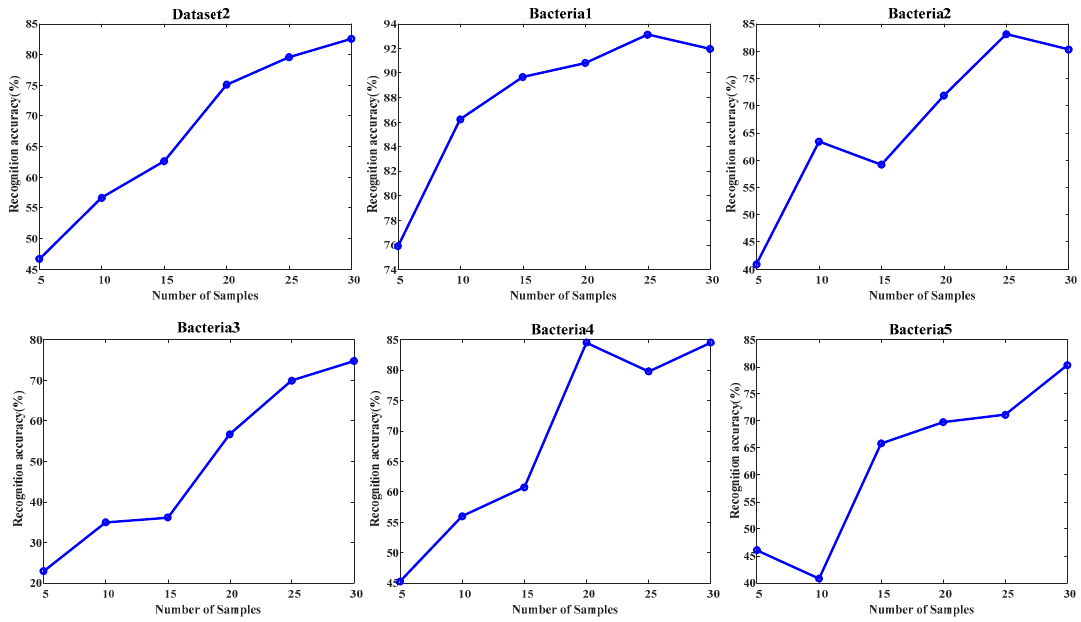
Figure 8. Recognition accuracy (%) with respect to different number of target samples used to calculate the target